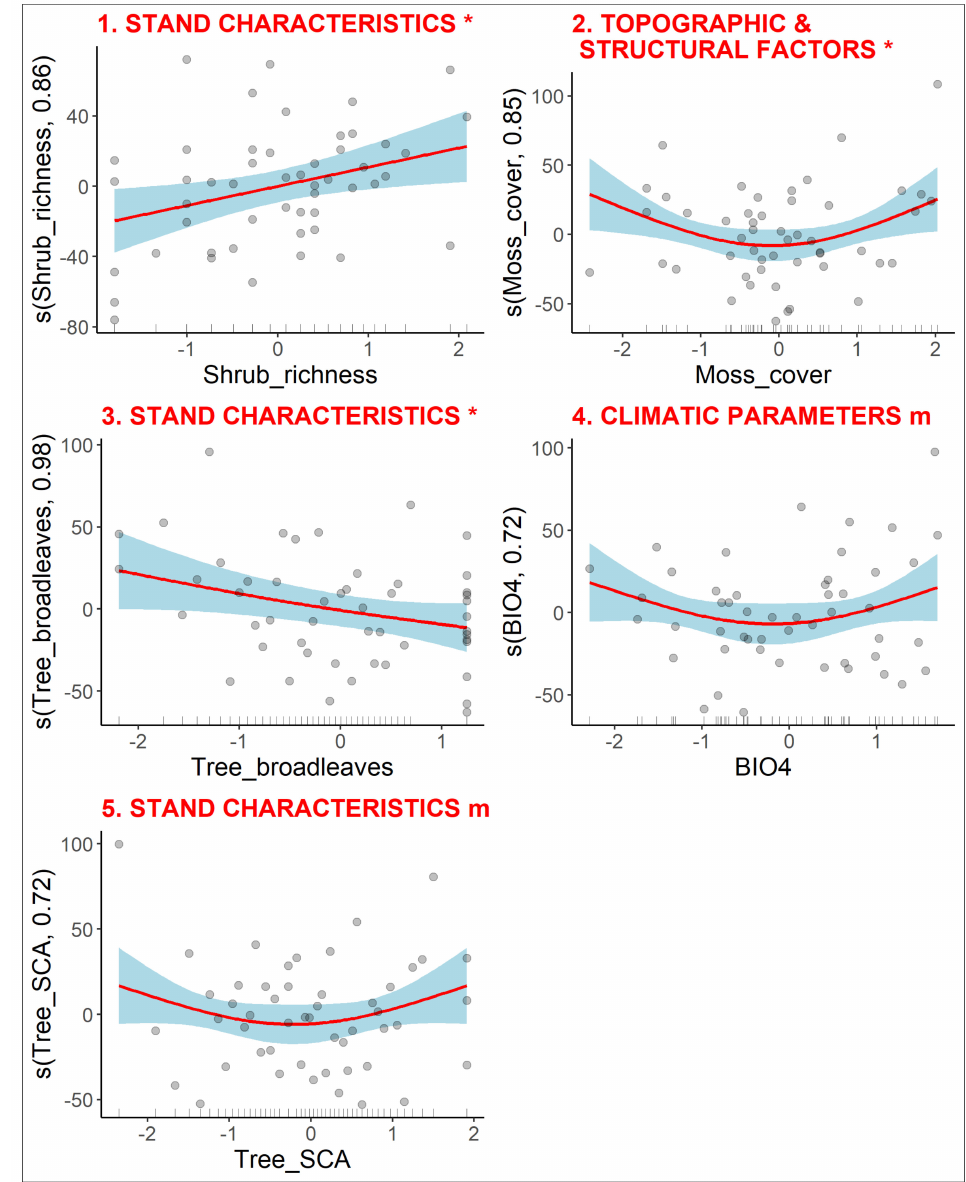
Figure 3. The estimated relationships between the herb-layer cover and five explanatory variables included in the final GAM: shrub layer richness, moss layer cover, proportion of broadleaves in the tree layer, temperature seasonality (BIO4) and tree-layer shade-casting ability (SCA). The order of predictors reflects their effect size and significance: * p < 0.05, m (marginally significant)— p < 0.1. The confidence interval (95%) is indicated with the light-blue ribbon around each curve. For additional definition of predictors, see Table